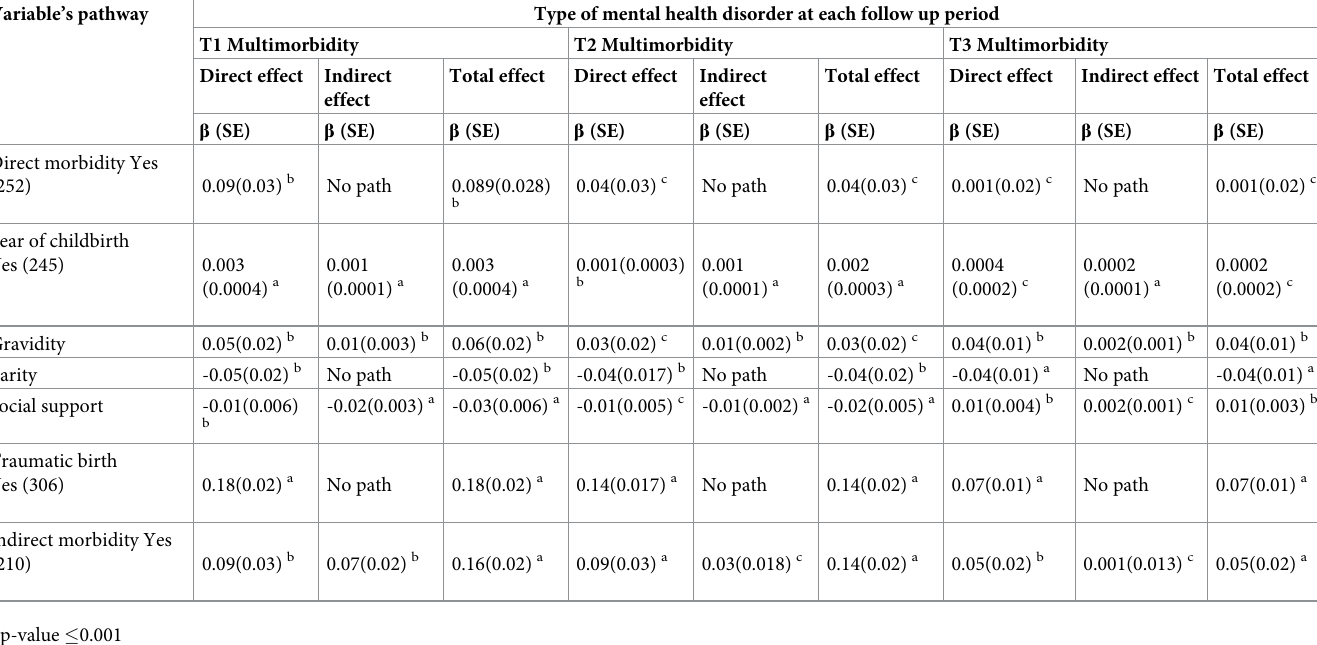
Table 8. Direct, indirect and total effects of variables associated with multimorbidity, among postpartum women in Northwest Ethiopia, 2021. Variable’s pathway Type of mental health disorder at each follow up period T1 Multimorbidity T2 Multimorbidity T3